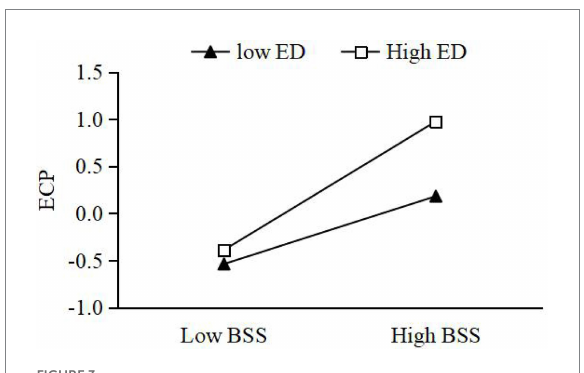
FIGURE 3 Moderating effect of environmental dynamism (ED) between boundary-spanning search (BSS) and economic performance (ECP).